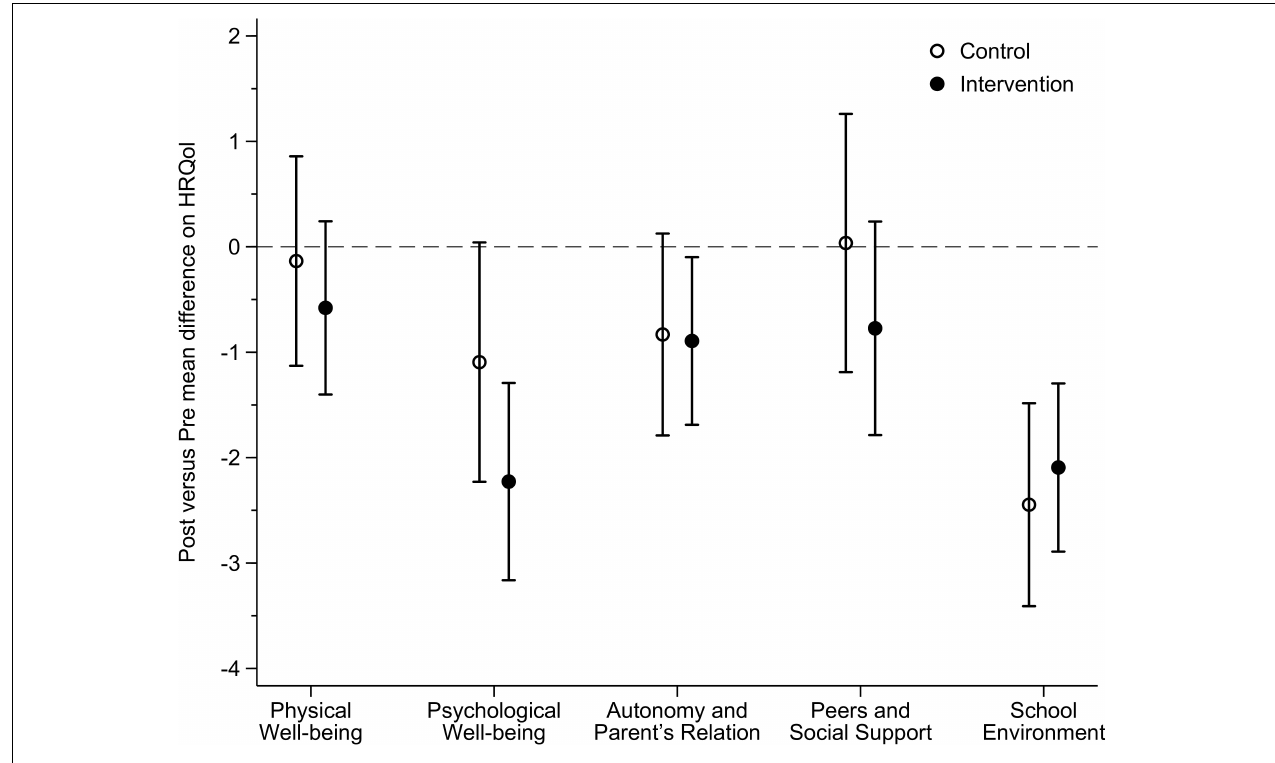
FIGURE 2 | Effect of the Movimente Program on dimensions of HRQoL among total